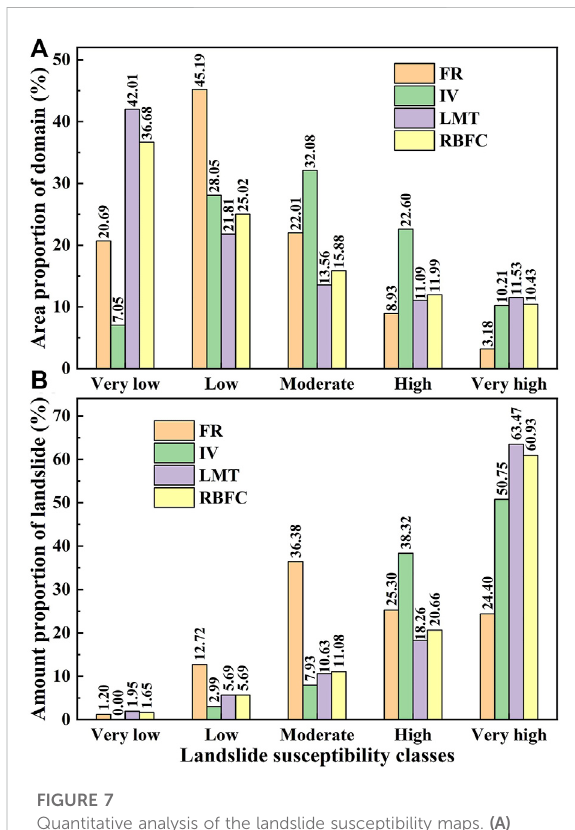
FIGURE 7 Quantitative analysis of the landslide susceptibility maps. (A) Area proportion of domain in each susceptibility class. (B) Amount proportion of landslide in each susceptibility